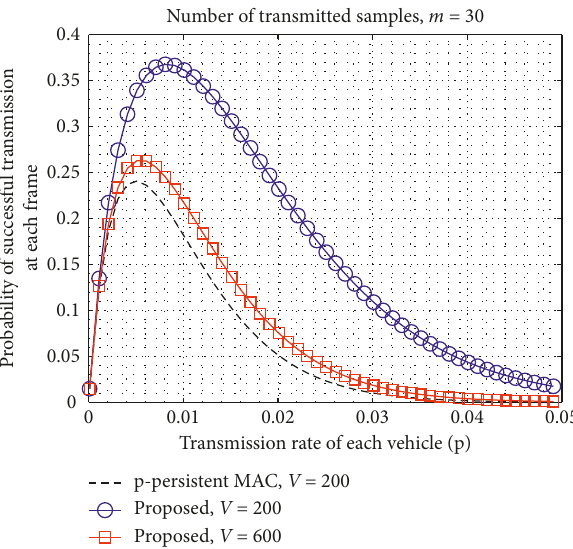
Figure 9: Probability of successful reception of a packet versus the transmission load for different values of V while M is